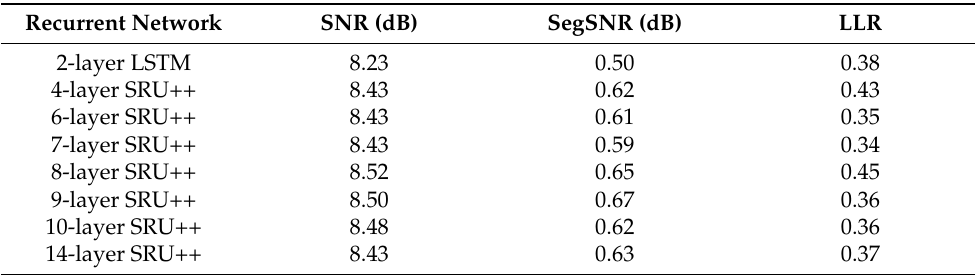
Table A1. Comparison of the model performance with LSTM, and different layers of SRU++ at 150 epochs.